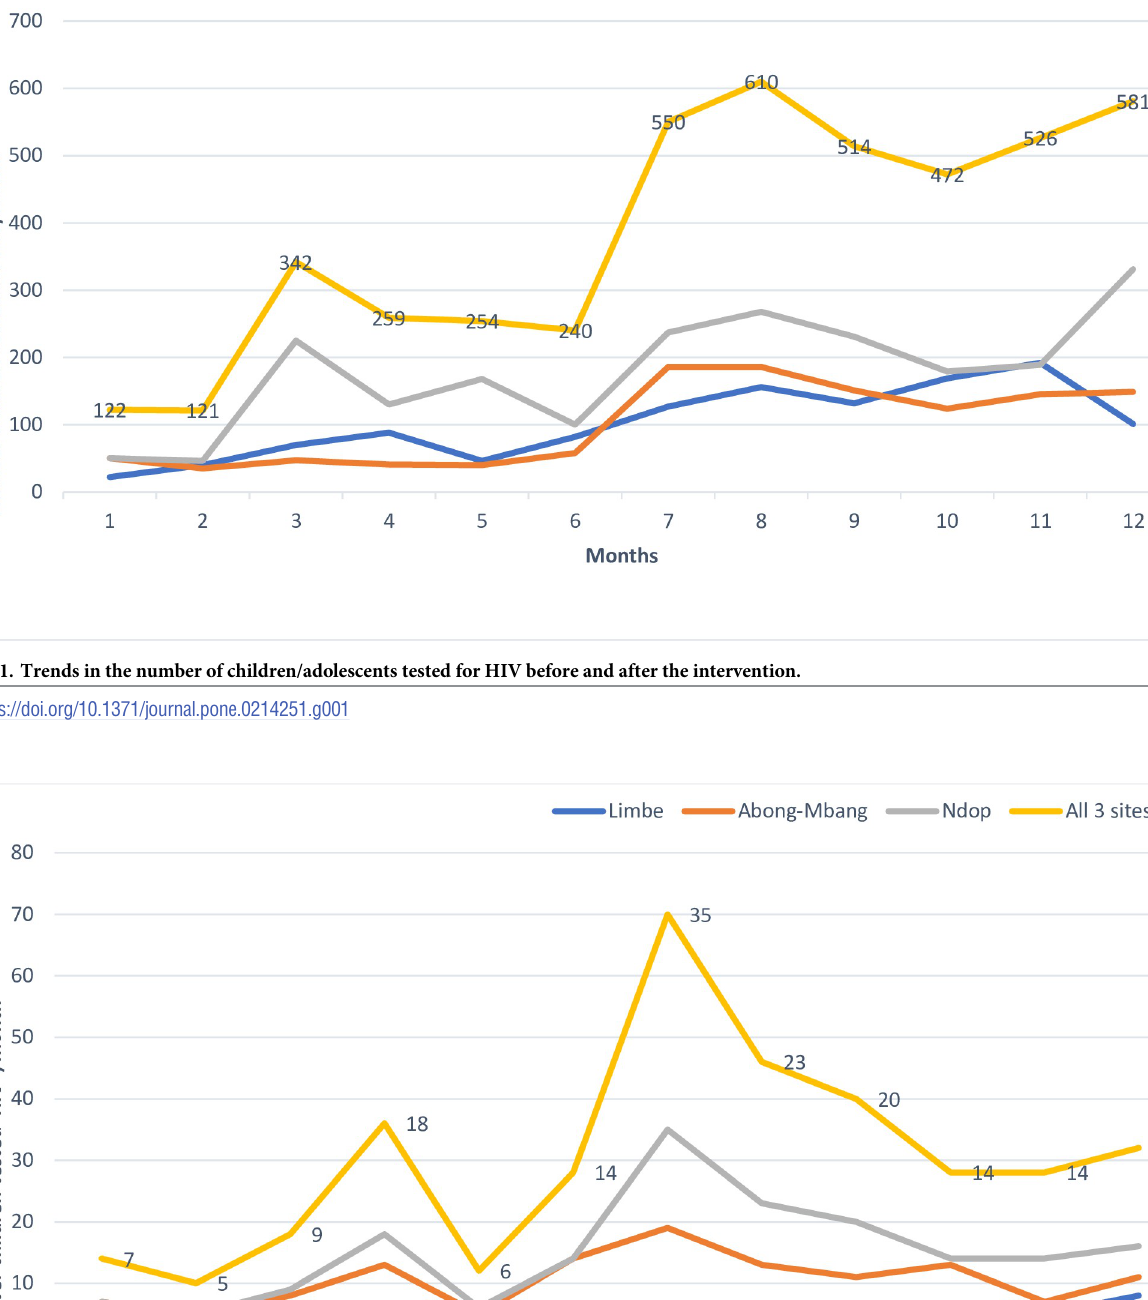
PLOS ONE | https://doi.org/10.1371/journal.pone.0214251 May 6,